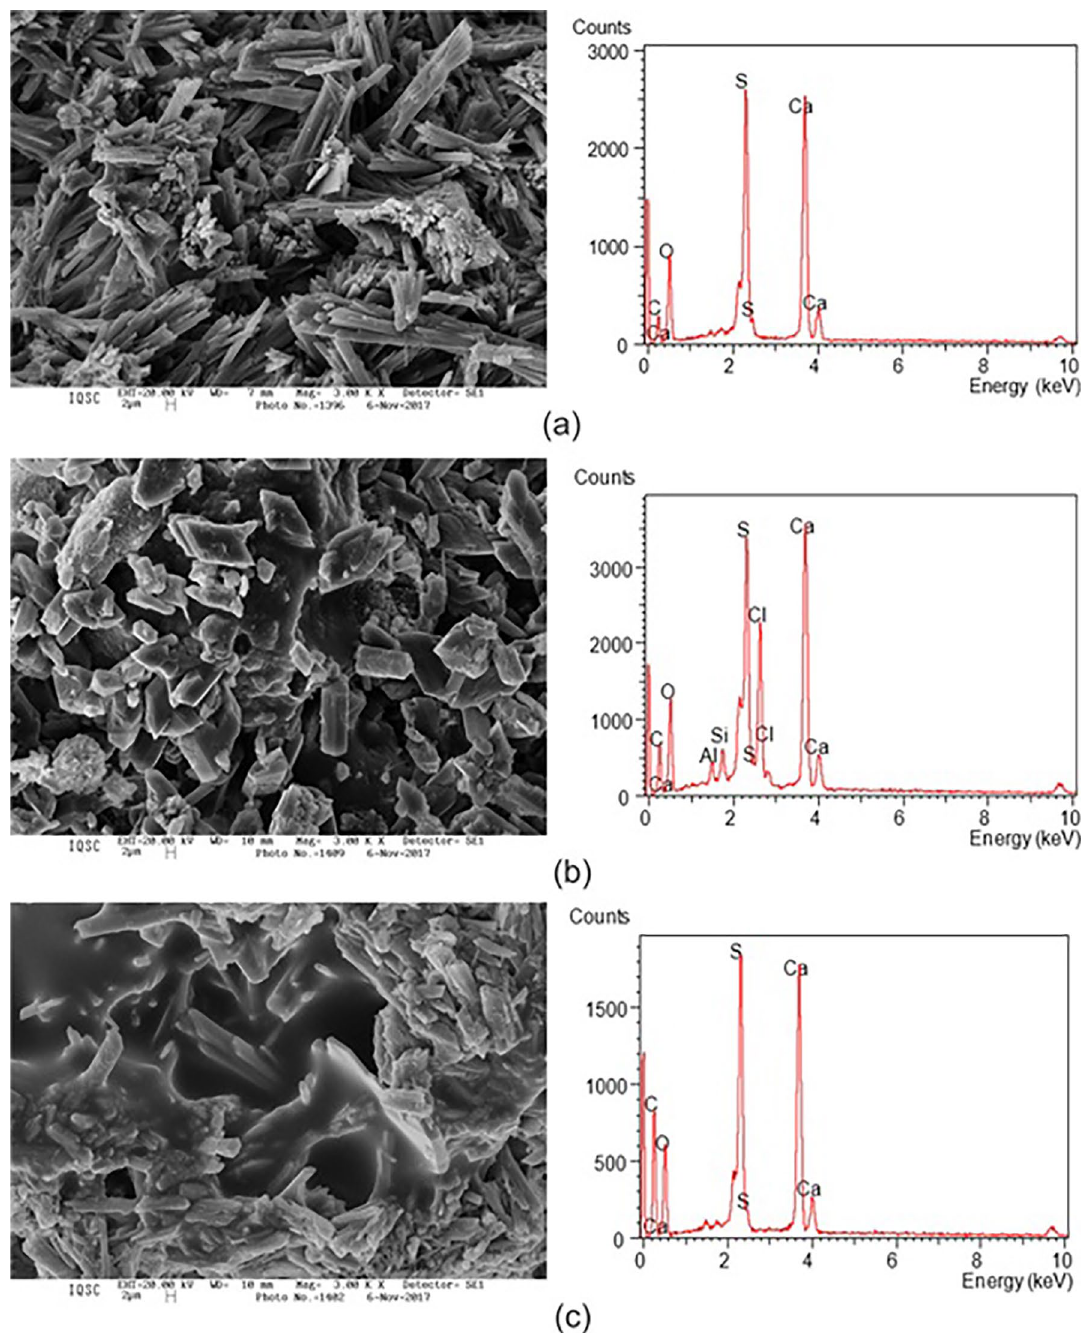
Figure 7. SEM and EDS of the sample with addition of 5% polymer: (a) EVA; (b) VA/VL/VC; (c)